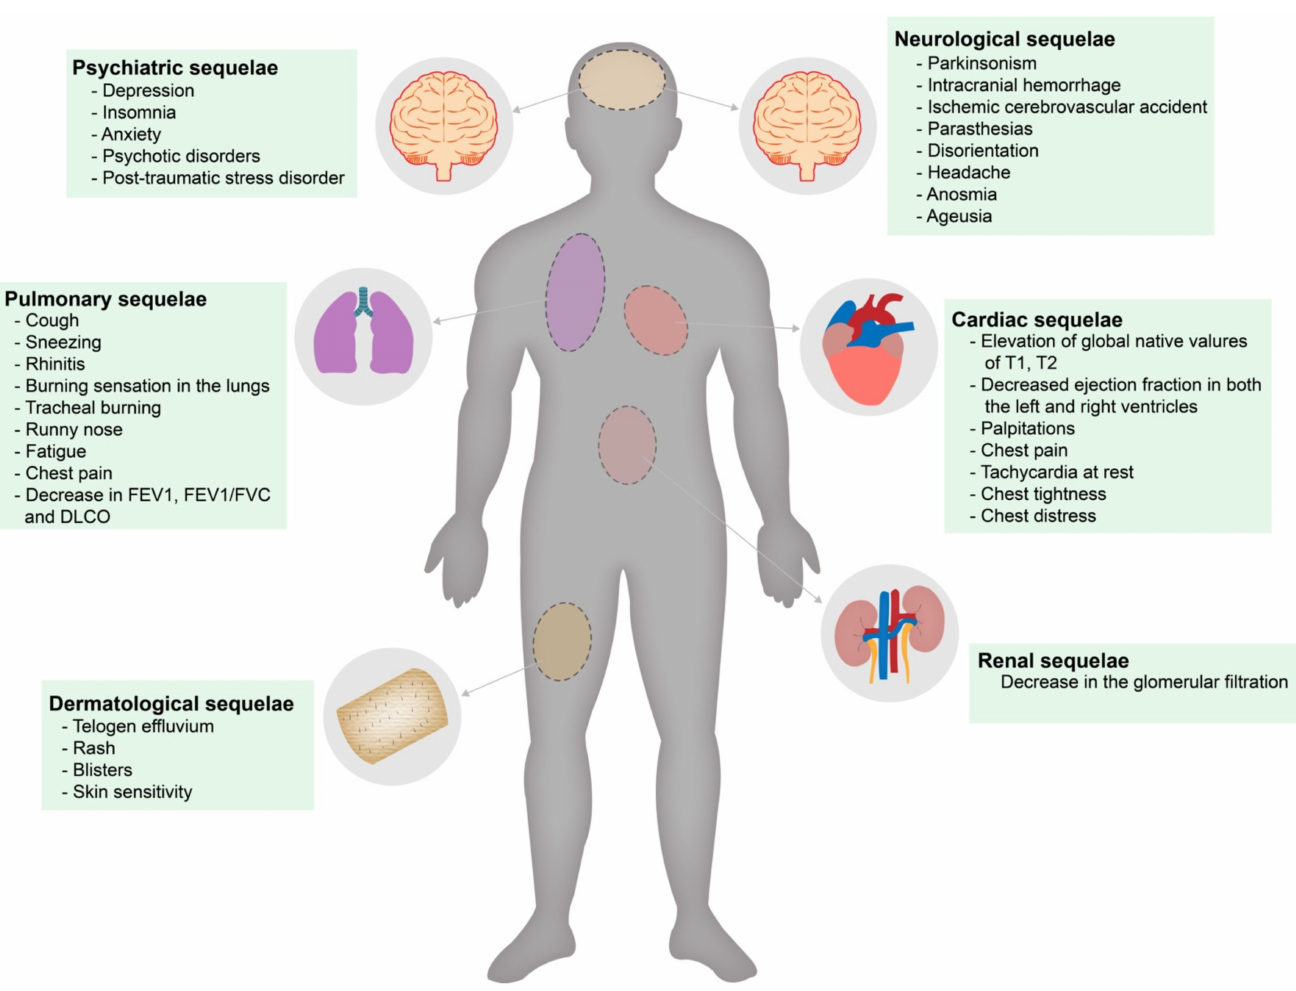
Figure 2. The main reported post-COVID-19 sequelae and long-term symptoms attributed to long